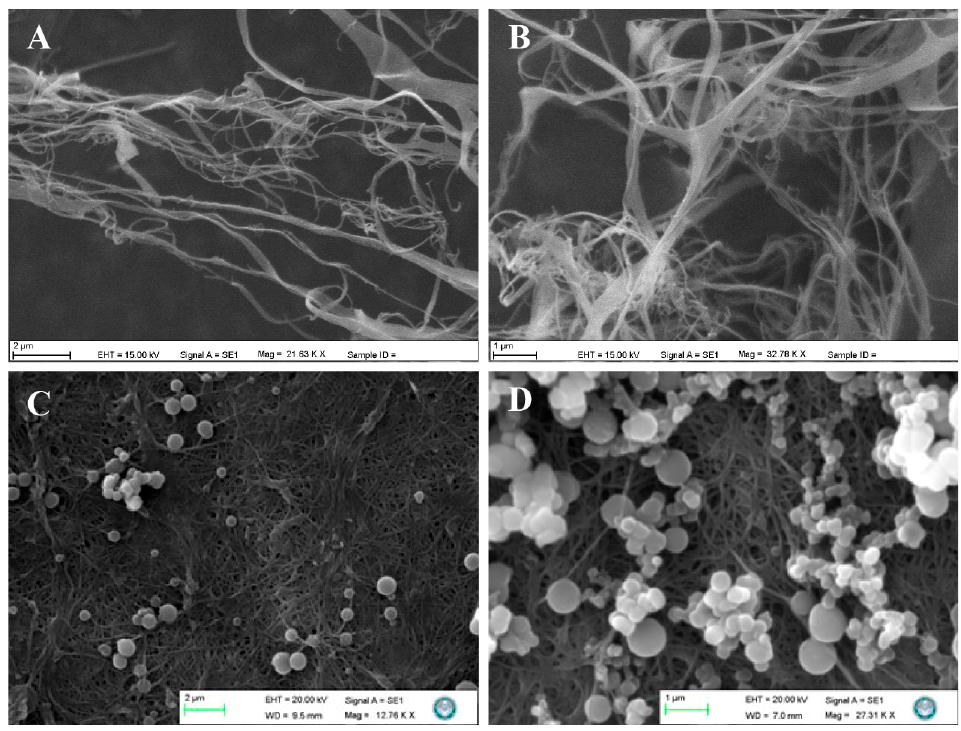
Figure 2. SEM images. ( A , B ) BC-NFs; ( C , D ) E2-NP/BC-NFs.